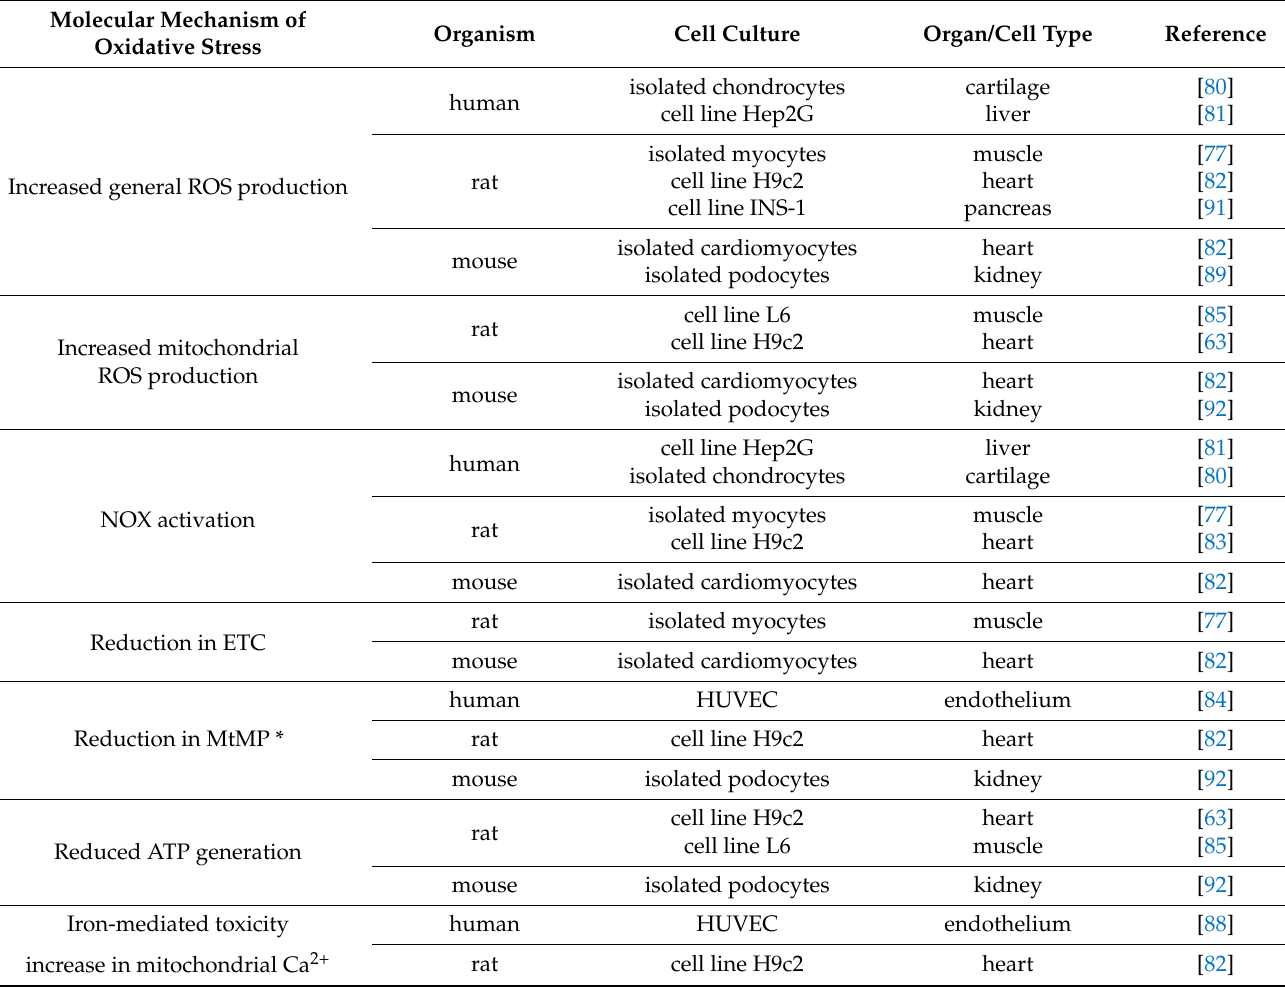
Table 1. Selected molecular mechanisms of lipotoxic oxidative stress and their sites of confirmed